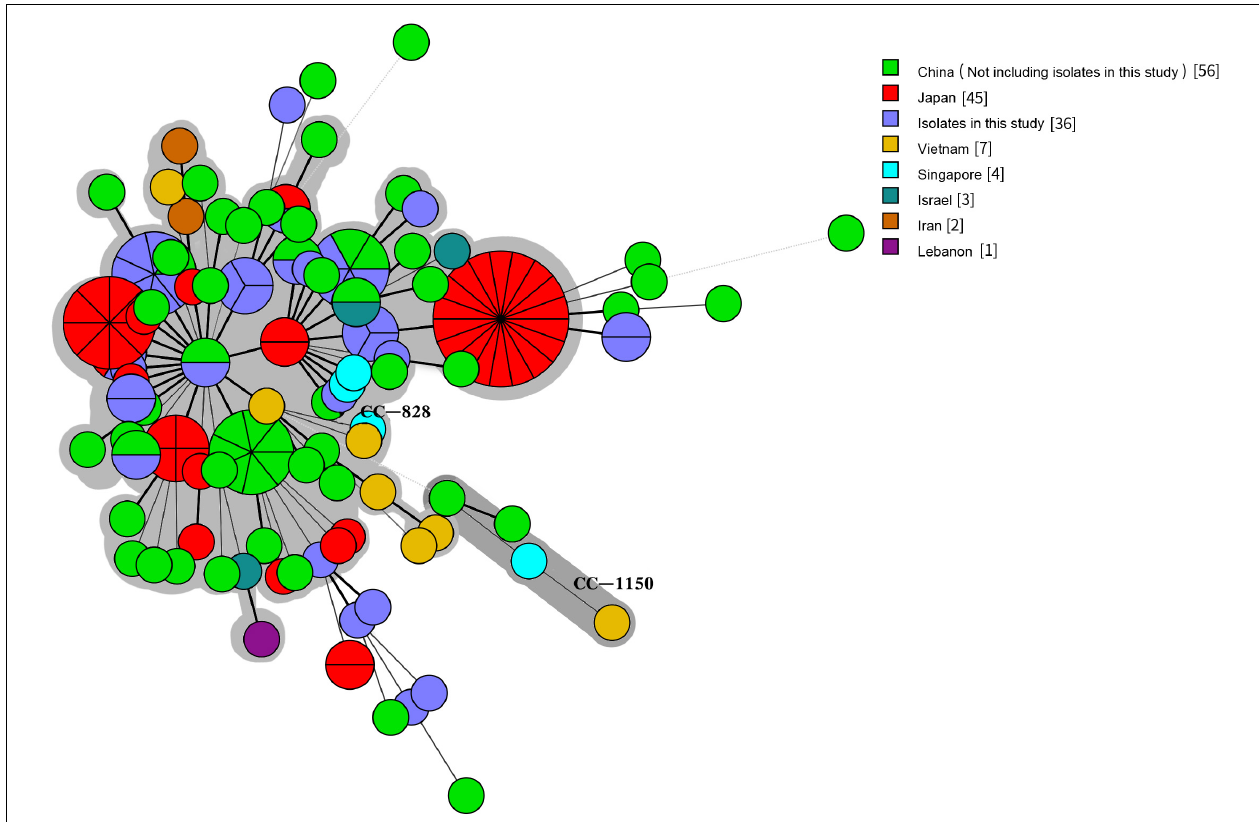
FIGURE 6 | Genetic relationships among the 36 clinical isolates C. coli in this study and 118 isolates C. coli from Asia in the pubmlst database (Data taken time: January 18, 2019). A minimum spanning tree was reconstructed based on CCs from this study and the MLST database. The size of circles is proportional to the number of isolates, and the sources of isolates are colored as indicated. Shadow zones in different color represent different clonal